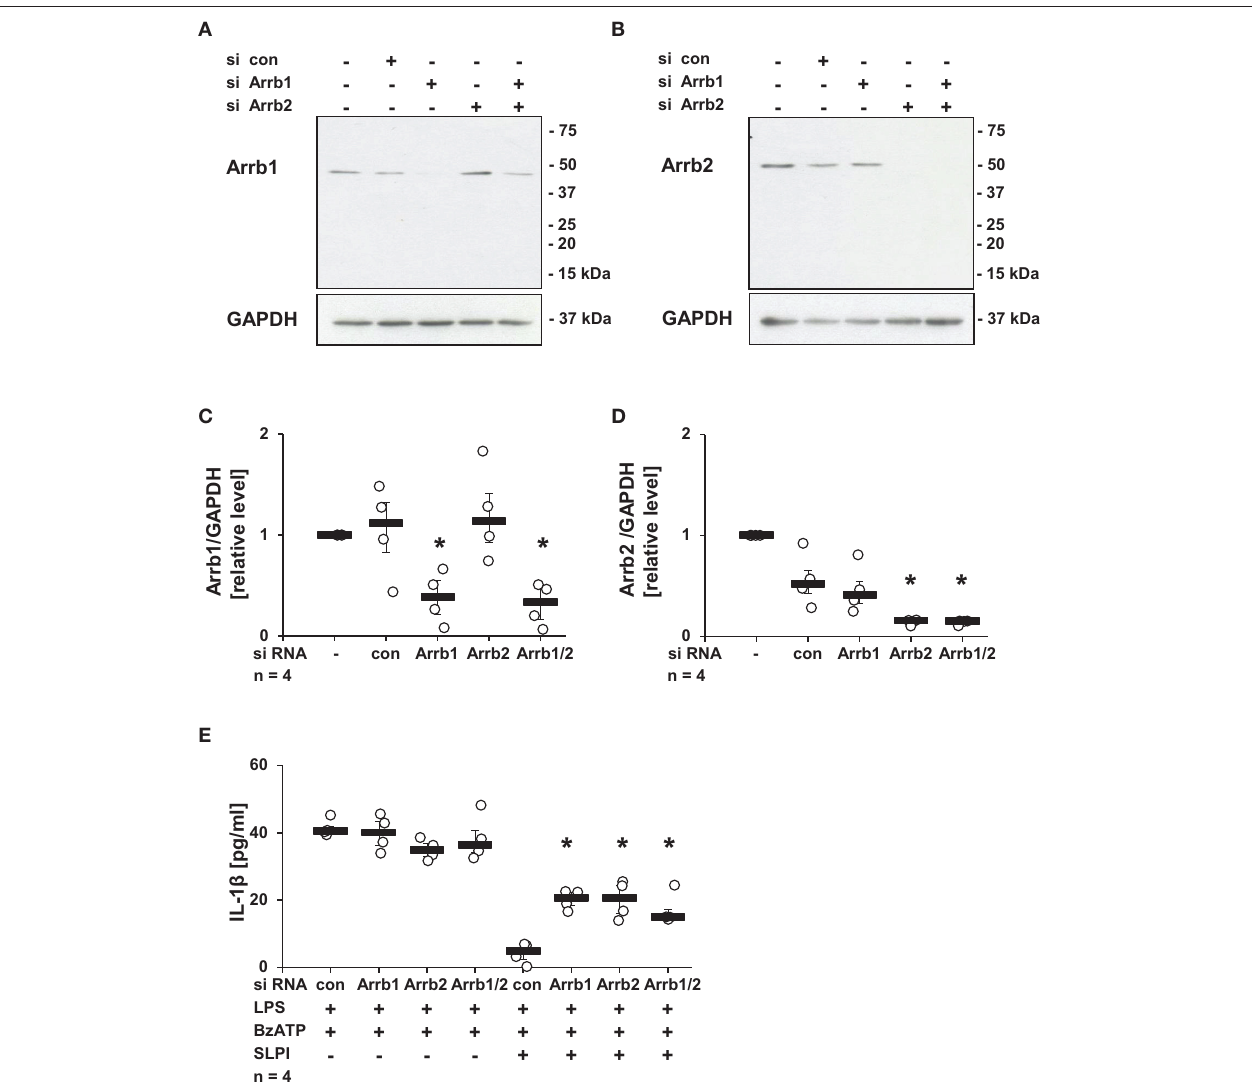
FIGURE 9 | SLPI signaling involves arrestin β 1 and 2 (Arrb1/2). Expression of Arrb1 or Arrb2 in U937 cells was diminished using siRNA. Afterwards, cells were primed with LPS (1 µ g/ml, for 5h) and further stimulated with 2 ′ (3 ′ )-O-(4-benzoylbenzoyl)adenosine 5 ′ -triphosphate triethylammonium salt (BzATP; 100mM) for 30min in the presence or absence of SLPI (10 µ g/ml). The efficiency and specificity of the knock-down was confirmed by immunoblotting. The concentration of IL-1 β in cell culture supernatants was measured by ELISA. (A,C) The expression level of Arrb1 was selectively lowered upon transfection with Arrb1 siRNA; (A) representative immunoblot out of 4 (B,D) The expression level of Arrb2 was diminished upon transfection with Arrb2 siRNA; (B) representative immunoblot out of 4. (C,D) Optical density of the immune-positive bands for Arrb1 or Arrb2 was measured and divided by the values obtained for β -actin on the same blot. The values gathered from untreated cells were set to one and all other values were calculated accordingly. * p ≤ 0.05 significantly different compared to cells transfected with control (con) siRNA. (E) Down-regulation of the expression of Arrb1 or Arrb2 by siRNA blunted the SLPI-induced inhibitory effect. * p ≤ 0.05 significantly different compared to cells transfected with control siRNA (con) and stimulated with LPS, BzATP and SLPI. Experimental groups were compared by Kruskal-Wallis test followed by Mann-Whitney rank sum test.